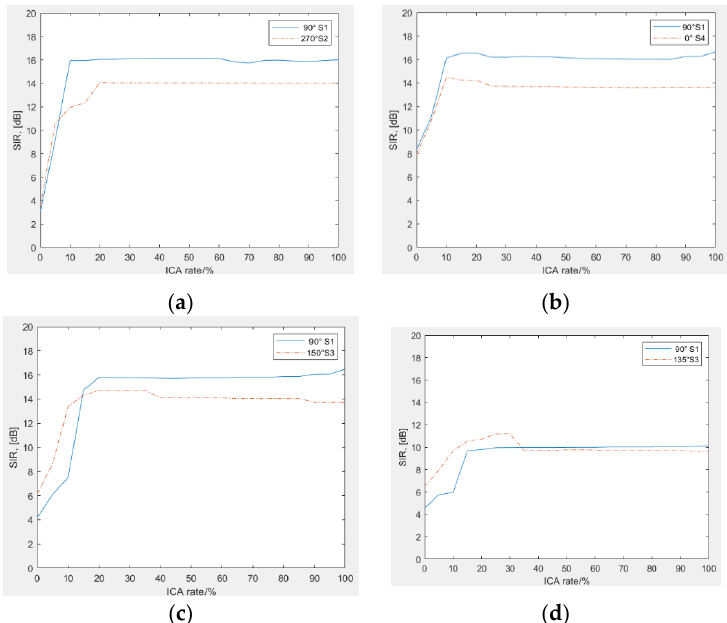
Figure 6. Signal-to-interference ratio (SIR) improvement with separation under dual sources in Room A. (a)-(d) correspond to SET1-SET4, respectively.